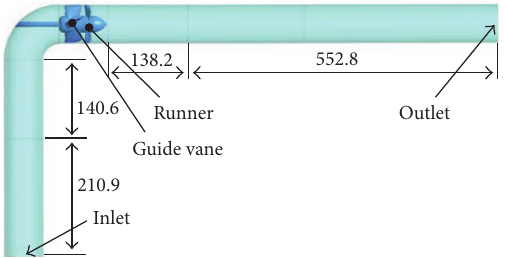
Figure 15: Computational